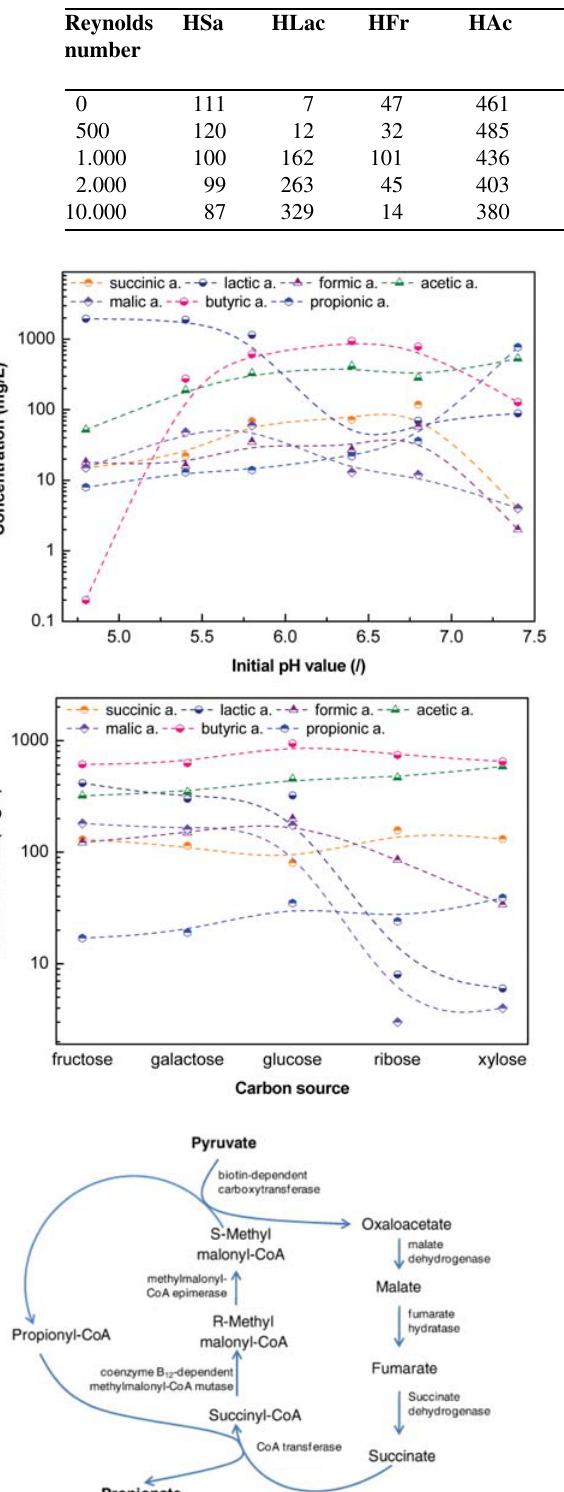
Table 5. Influence of mixing intensity on volatile fatty acids distribution (HSa, succinic; HLac, lactic; HFr, formic; HAc, ace- tic, HMal, malic; HPr, propionic; HBu, butyric acid) and hydrogen yield. Reynolds